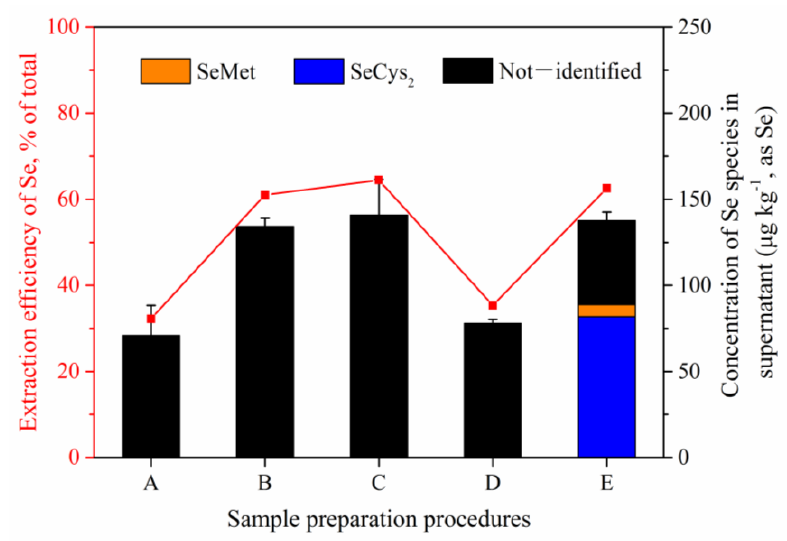
Figure 1. Extraction efficiency of Se and concentration of Se species in supernatant with different preparation procedures: (A) Extraction with ultrapure water; (B) Extraction with HCl (0.1 M); (C) Extraction with NaOH (0.1 M); (D) Extraction with 20 mM ammonium acetate solution containing 5% of methanol ( v / v ); (E) Hydrolysis with protease XIV. The value of Se in supernatant minus the observed Se species was defined as the “not-identified” Se species. Table 1. Concentration and spike recoveries of SeCys 2 , MeSeCys, and SeMet in eggs using different extraction solution (Results expressed as the mean ± standard deviation